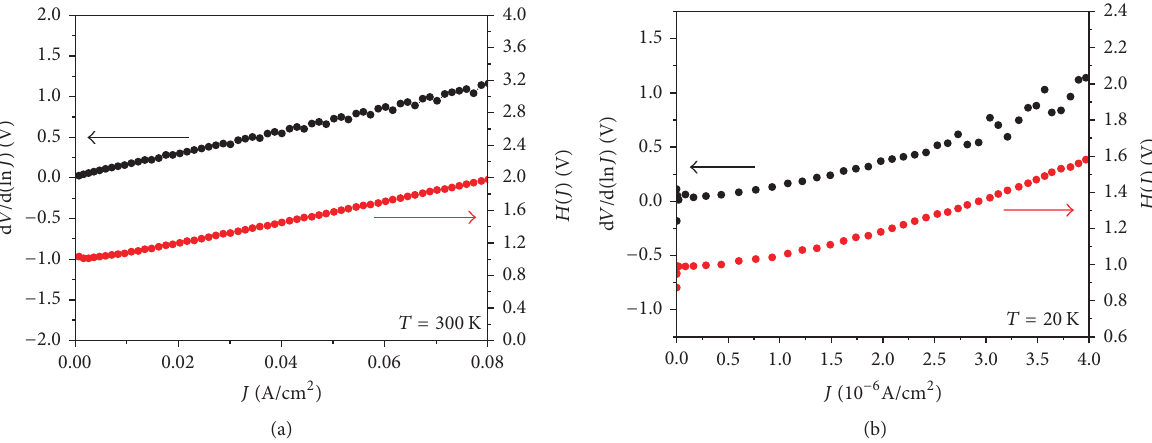
Figure 5: Arrhenius plot for log 𝐽 0 versus 1000/ T . The inset is a plot of the 𝜙 𝑏 value versus temperature.